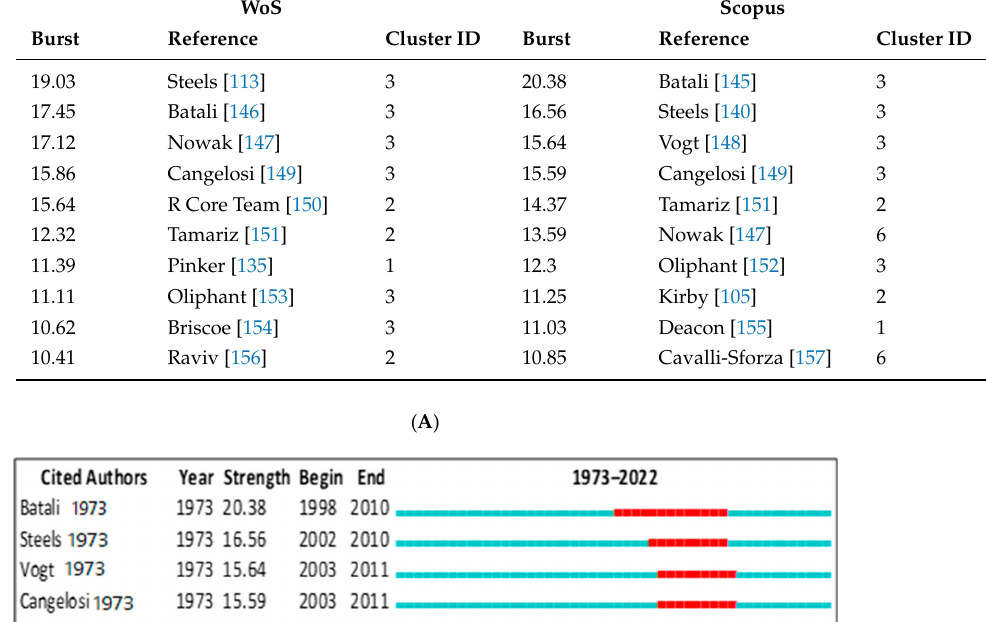
Table 6. Citation bursts of biolinguistics by references using scientometric indicators.